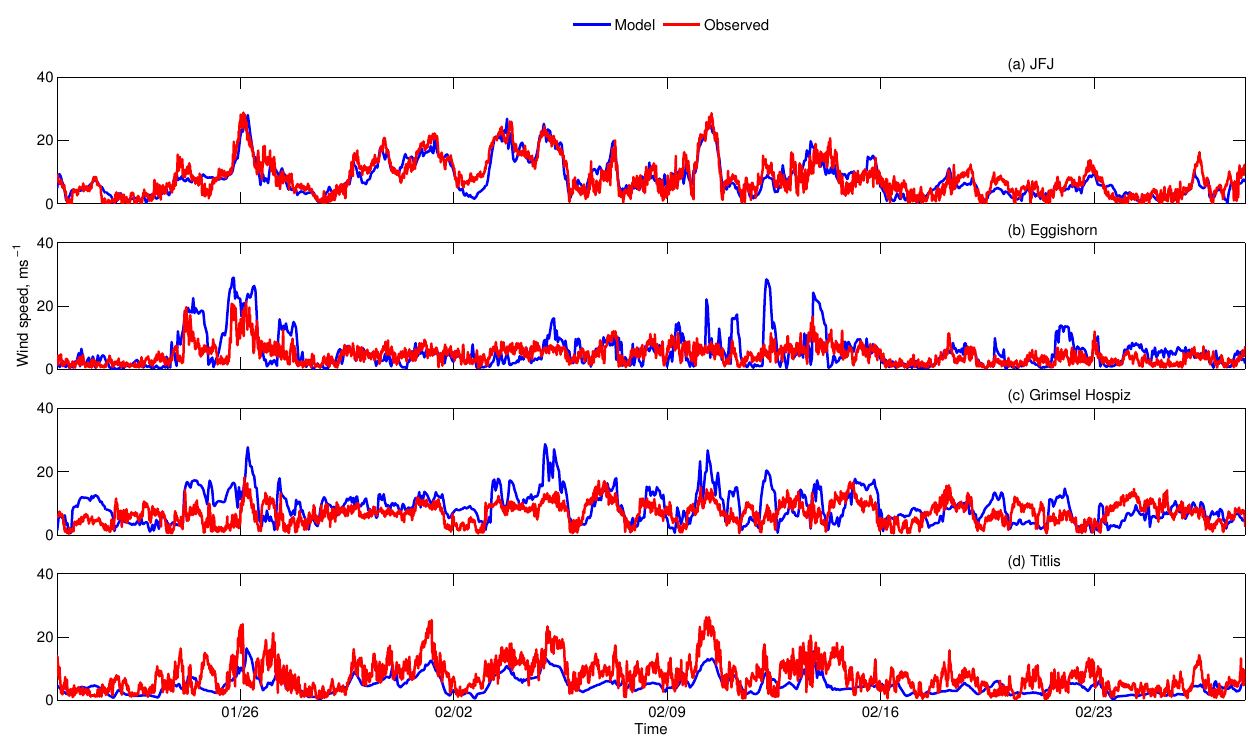
Figure 4. A comparison of the wind speed at four MeteoSwiss observation stations with the WRF control simulation during the INUPIAQ field